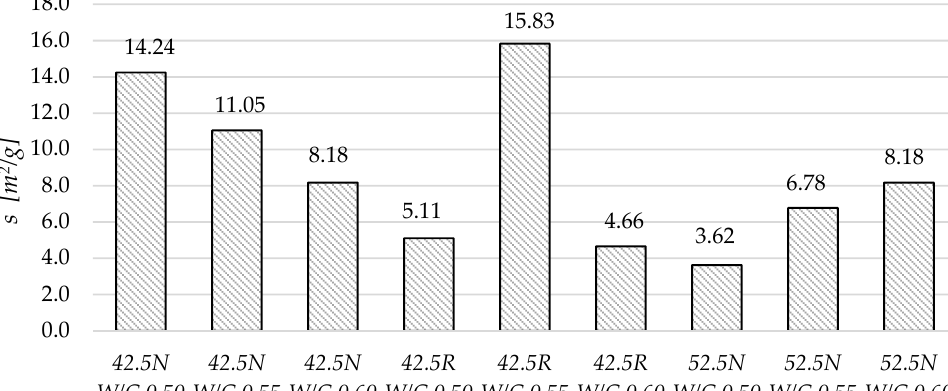
Figure 13. The relation between the thermal conductivity, λ , and total porosity, p (MIP). The same situation occurred in the relation between the thermal conductivity and the total surface area. Again, in the variants based on CEM 42.5N and CEM 52.5N, the correlations are very strong. In the group 42.5N, with the increasing λ , the total surface area rises. In the group 52.5N, with the increasing λ , the total surface area decreases. In the 42.5R variant, the specimen W/C 0.55 is characterized by a definitely higher value of total surface area than the other two specimens. In Figure 14, the relations between the water absorptivity and microstructural parameters are shown. With the increase of the porosity, the water absorbability increases for all three variants of the mortars. Overall, the coefficient of determination for all 9 specimens is quite high and confirms the relationship between the parameters.